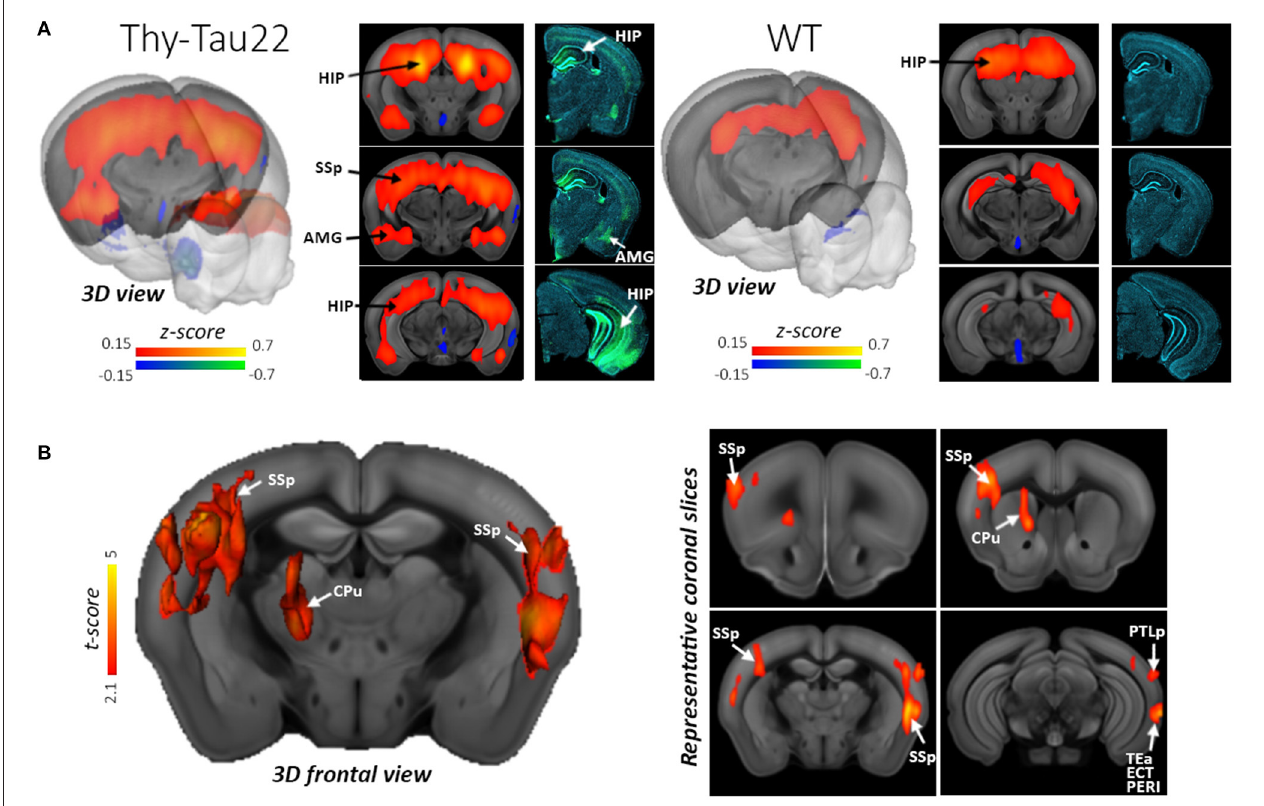
FIGURE 4 | Hyperconnectivity of the dorsal Hippocampus (dHIP) in Thy-Tau22 mice. (A) 3D rendering and coronal slices of the seed-based analysis of the dHIP network showing the mean correlation between the mean BOLD signal in the dHIP and all other voxels of the brain, in Thy-Tau22 and wild-type (WT) mice. The color scale represents the strength of the functional correlation normalized with a Fisher z-transformation. Corresponding coronal slices of immunofluorescence staining are shown in the right column in Thy-Tau22 and WT mice: staining of phosphorylated tau (AT8 antibody in green) and DAPI (blue). (B) 3D slice representation and maps (right side) of statistically significant differences between the groups (two sample t -test, P5 0.01, FDR cluster corrected) showing specific hyperconnectivity of the dHIP in Thy-Tau22 with primary somatosensory cortex (SSp) temporal associative (TEa), posterior parietal associative areas (PTLp), perirhinal cortex (PERI), ectorhinal cortices (ECT) and caudate putamen (CPu). Reproduced with permission from Degiorgis et al.